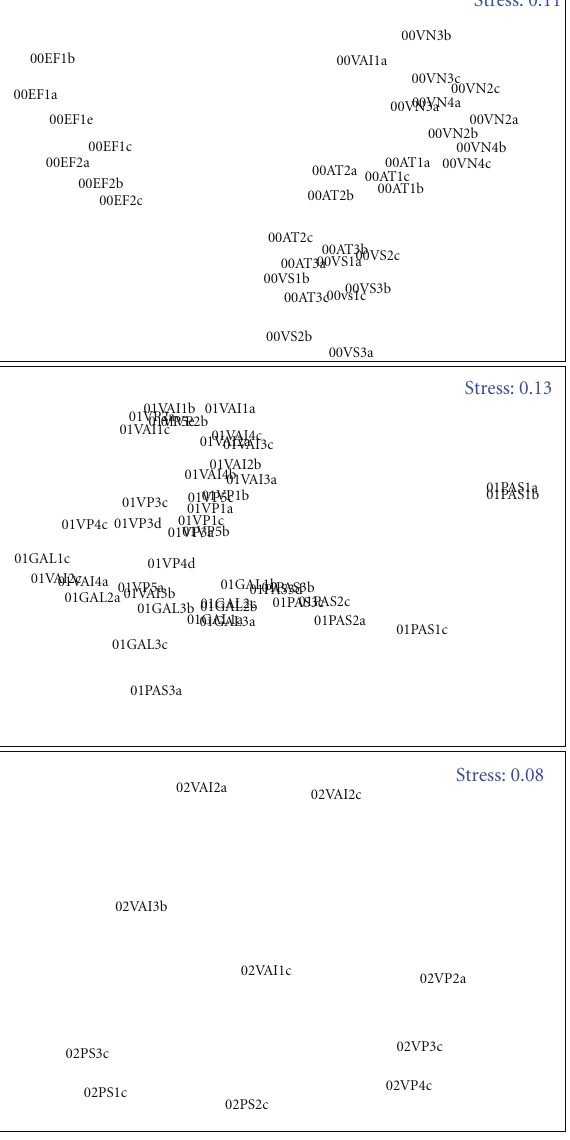
Figure 2: Plot of Multidimensional Scaling (MDS) using Bray- Curtis similarity matrix of macroinvertebrate abundances from 2000 (up) to 2002 (down). 1,2,3: pond replicates; a, b, c: spatial replicates within pond; 00, 01, 02: years; VN/VP: Vau; VAI: Vaia; AT: Atalaia; EF: Esteiro-Furado; VS: Vasa-Sacos; PAS: Passa, GAL: Gala; PS: Praias-Sado.